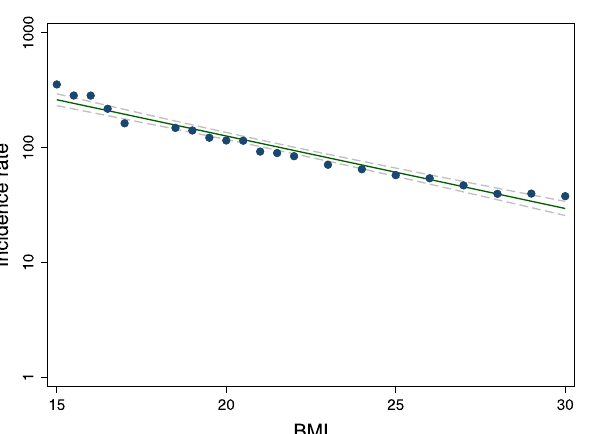
Figure 2. The inverse logarithmic relationship between body mass index and tuberculosis incidence rate in the study population The incidence rate was fitted by a linear model for body mass index (BMI) on a logarithmic scale to examine the association for the range of BMI 15–30. (R 2 =